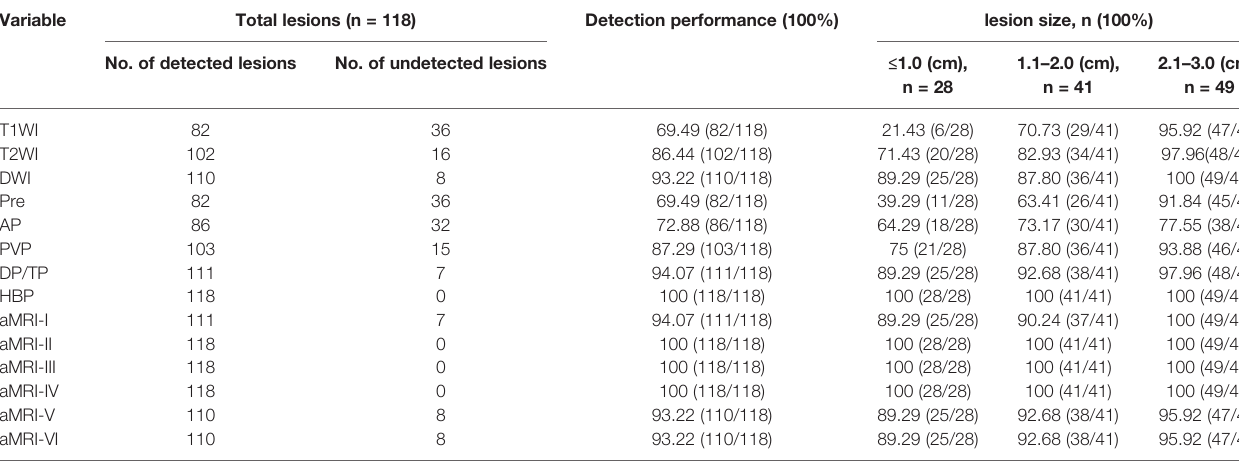
TABLE 1 | Detection performance of the MR sequence and aMRI protocols with